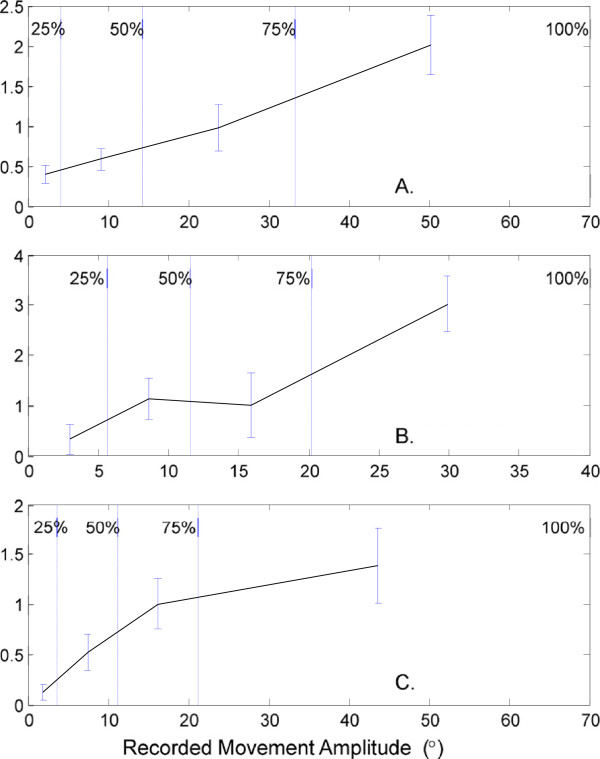
Error improvements by the NS as a function of recorded torso movement amplitudes. The RMSE improvement by NS was defined as RMSEMS –RMSENS. Recorded torso movement amplitude was defined as max – min angle. A: Flexion/extension, B: Axial rotation, and C: Lateral bending. Error bars indicate 95th percentile confidence intervals. 25%, 50%, 75%, and 100% denote 25th, 50th, 75th, and 100th percentile torso movement amplitudes, respectively.